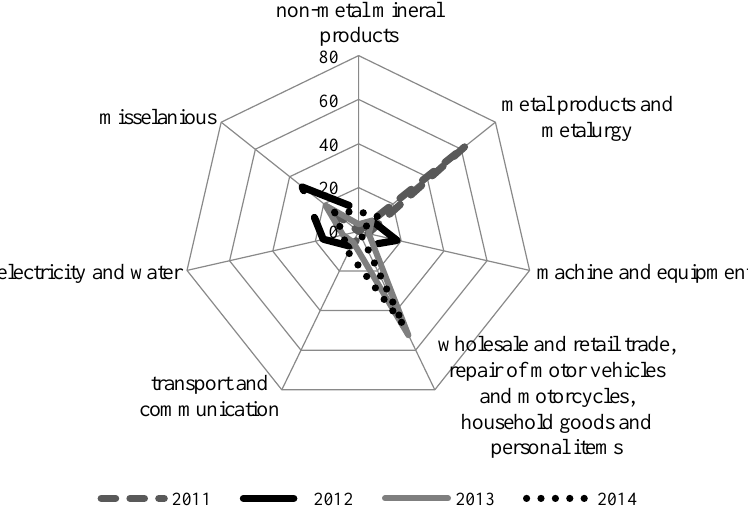
Fig. 2. Trends in changes in the structure of investments by types of fixed assets in 2011–2014.